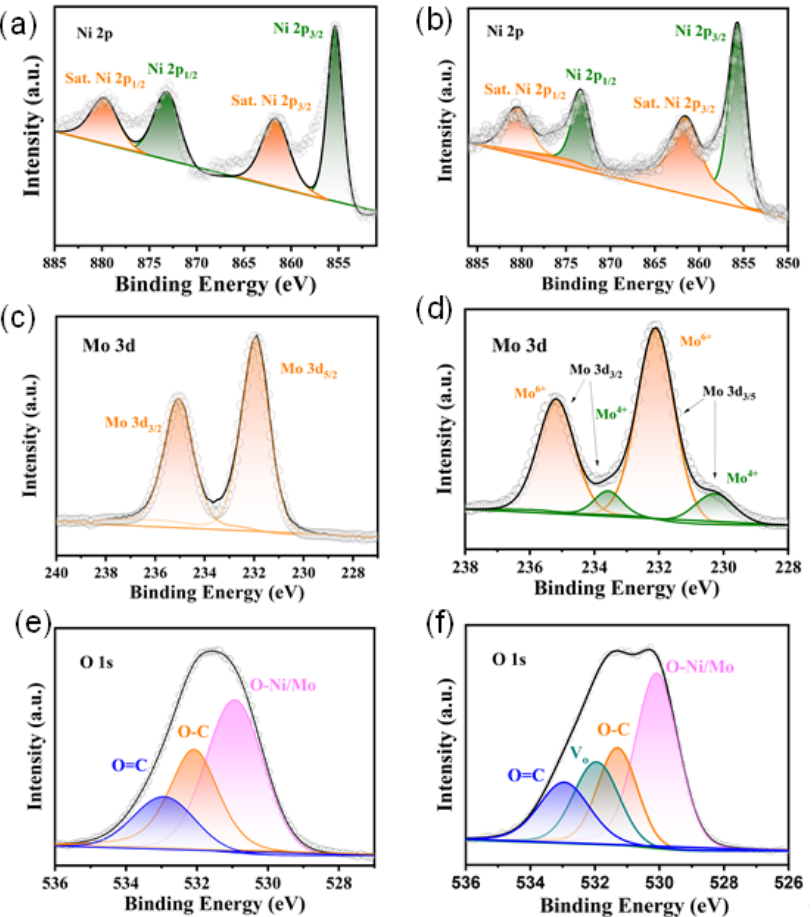
Figure 6. High-resolution XPS spectra of ( a , c , e ) pristine NiMoO 4 and ( b , d , f ) NiMoO 4 − x @C samples; ( a , b ) Ni 2p, ( c , d ) Mo 3d, ( e , f ) O 1s. ( a , b ) Ni 2p, ( c , d ) Mo 3d, ( e , f ) O